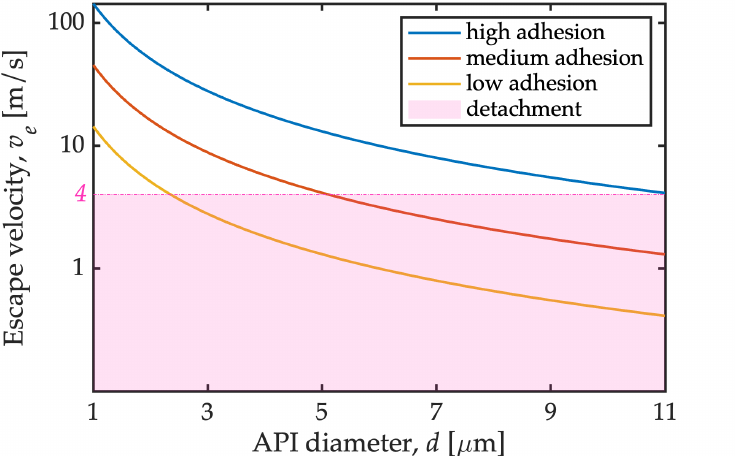
Figure 11. Escape velocity of particles in equatorial position as a function of API diameter and adhesion force (low: 2.5 nN, medium: 25 nN, high: 250 nN). The dashed line denotes the typical carrier–wall impact velocity reported in the literature